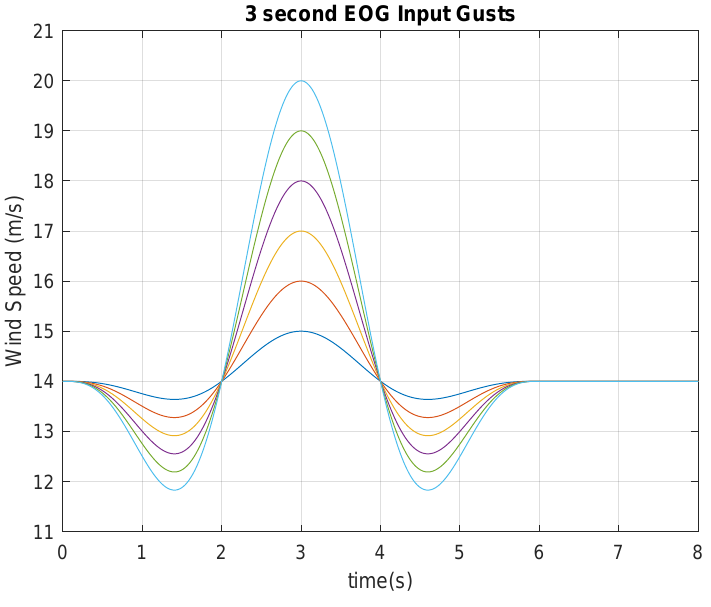
Figure 12. 3 s EOG test gusts applied. The corresponding gust factors for the 3 s, 5 s and 10 s rise time EOGs are calculated by integrating (1) with limits of ± 0.5 s of the peak gust time giving the sliding window of τ = 1 s and are displayed in Table 4. The 10 min moving average wind speed U T = 14 m/s. Table 4. EOG Input Gust